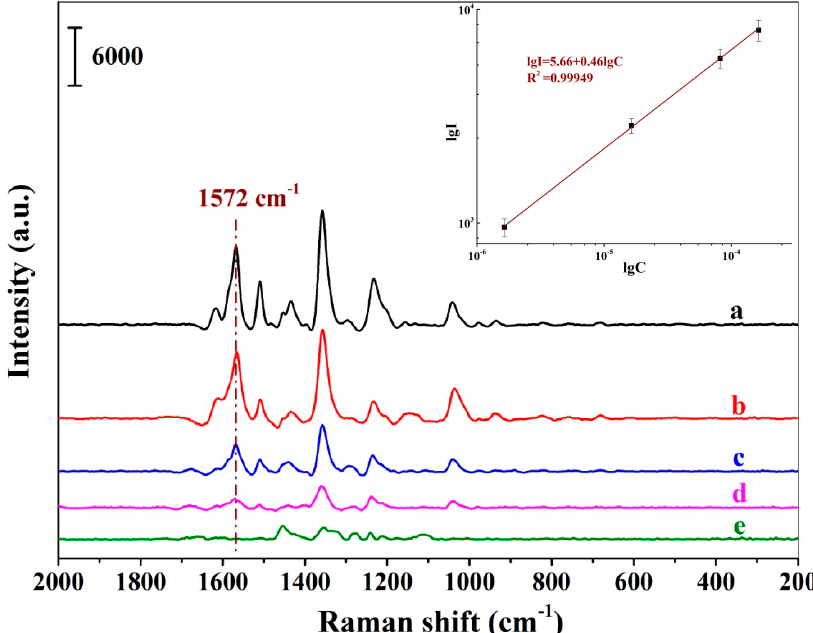
Figure 6. SERS spectra of New Red using the MIH substrate incubated with aqueous solutions of New Red at concentrations of 1.64 × 10 − 4 M ( a ), 8.18 × 10 − 5 M ( b ), 1.64 × 10 − 5 M ( c ), 1.64 × 10 − 6 M ( d ), and 1.64 × 10 − 7 M ( e ); (Inset: Linear correlation of the logarithmic peak intensity at 1572 cm − 1 versus the logarithmic concentrations of New Red).